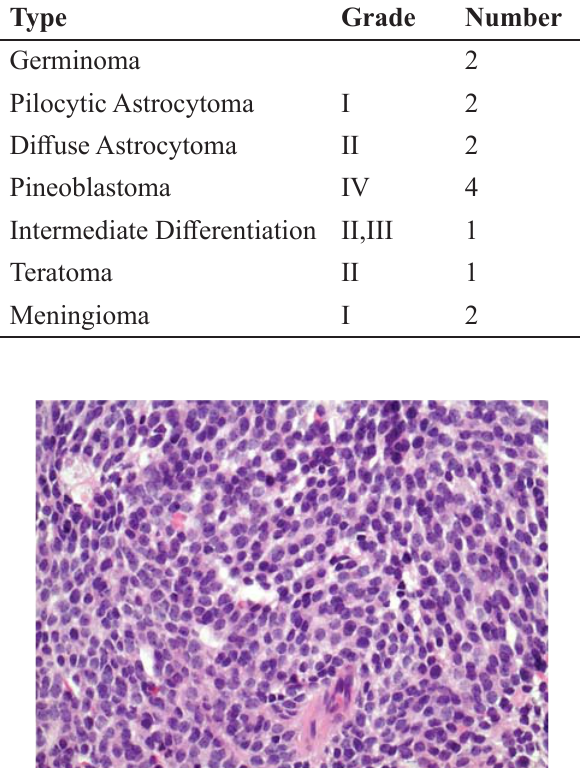
Table 1. Histopatology Type